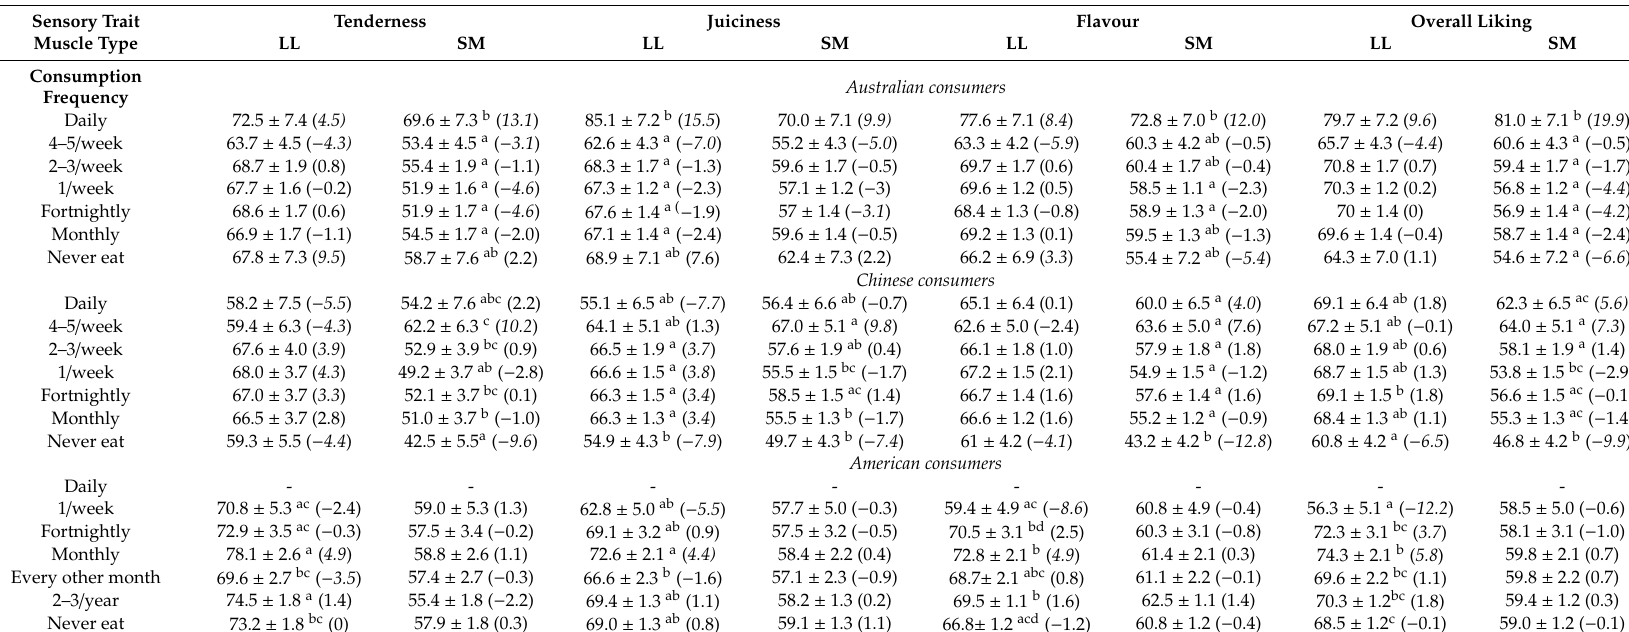
Table 5. Least square means ± standard error (on a scale of 0–100) of tenderness, juiciness, flavour and overall liking scores of LL and SM samples by a consumer’s consumption frequency of sheepmeat. Values within brackets signify di ff erence from mean of country and muscle type ( italics = greater than 3 units from the mea n). Sensory Trait Tenderness Juiciness Flavour Overall Liking Muscle